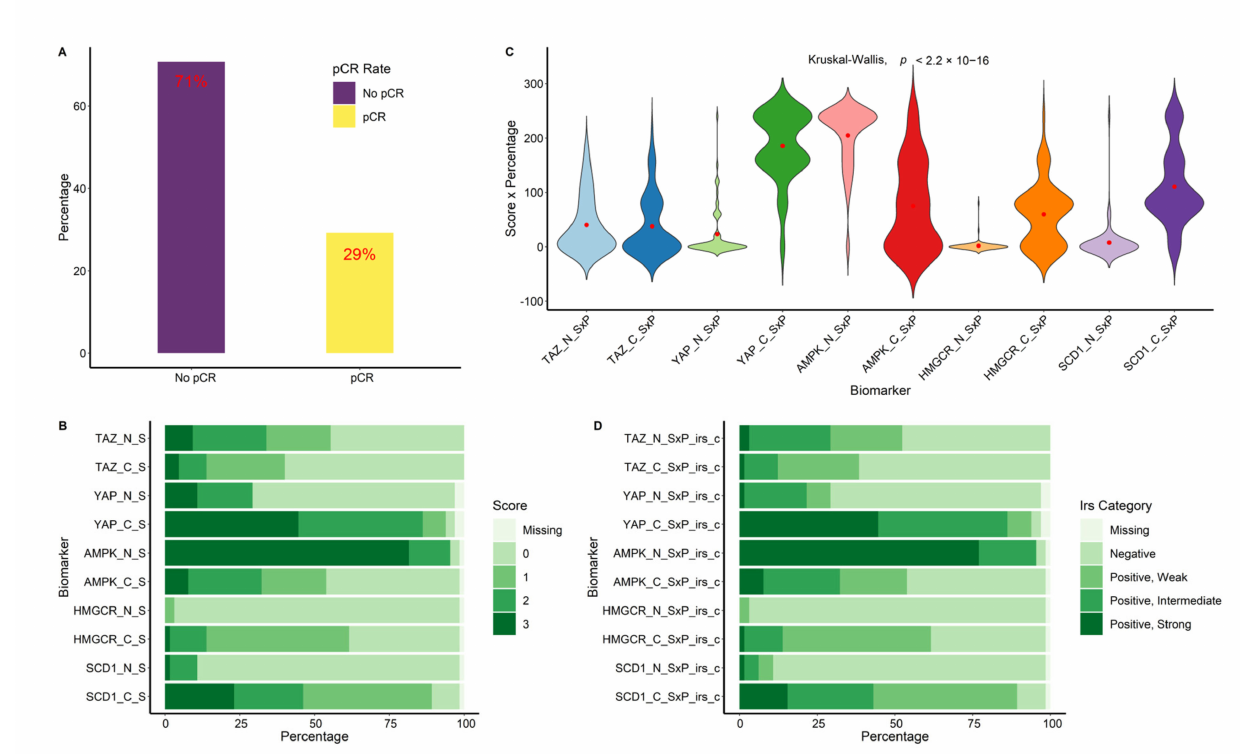
Figure 2. Panel ( A ) shows the rates of pathological complete response (pCR) and No pCR in the whole study population. The expression levels of the biomarkers in the nucleus (_N) and in the cytoplasm (_C) are shown in Panel ( B ) in terms of the immunoreaction intensity score (_S), in Panel ( C ) in terms of multiplication of the immunoreaction intensity score with the percentage of cells stained (_SxP), and in Panel ( D ) in terms of the categorized international immunoreactive score